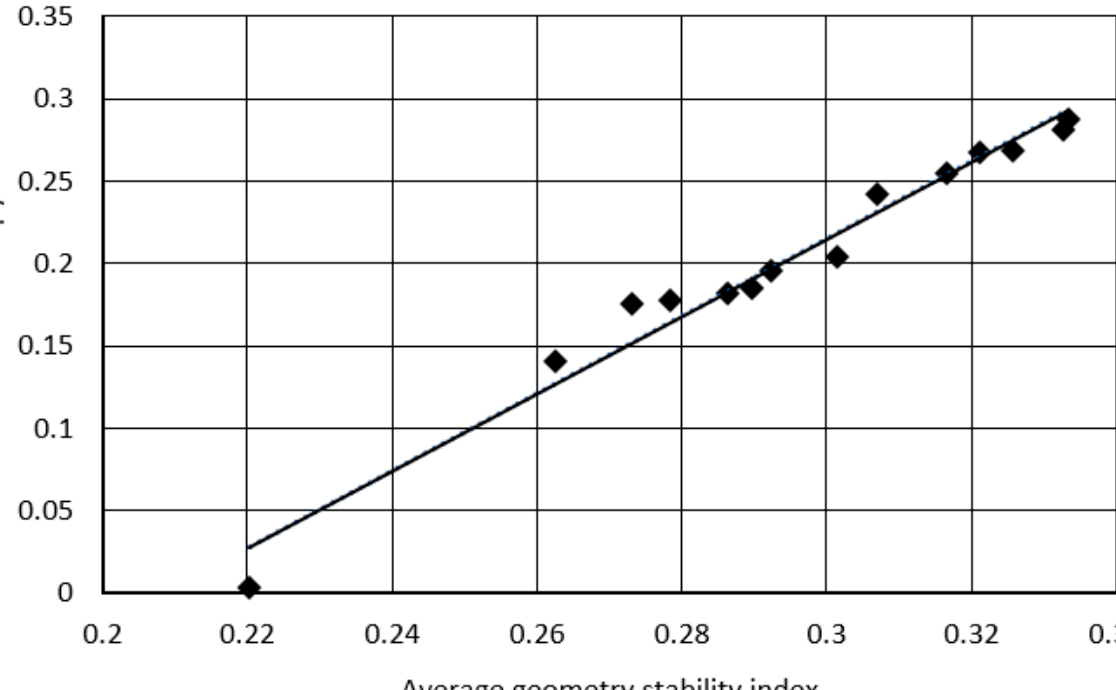
Figure 17. Average geometry stability index with fabric anisotropy.